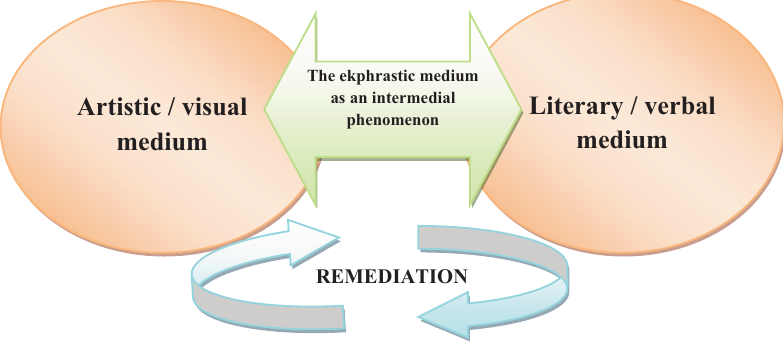
Fig. 1. The ekphrastic